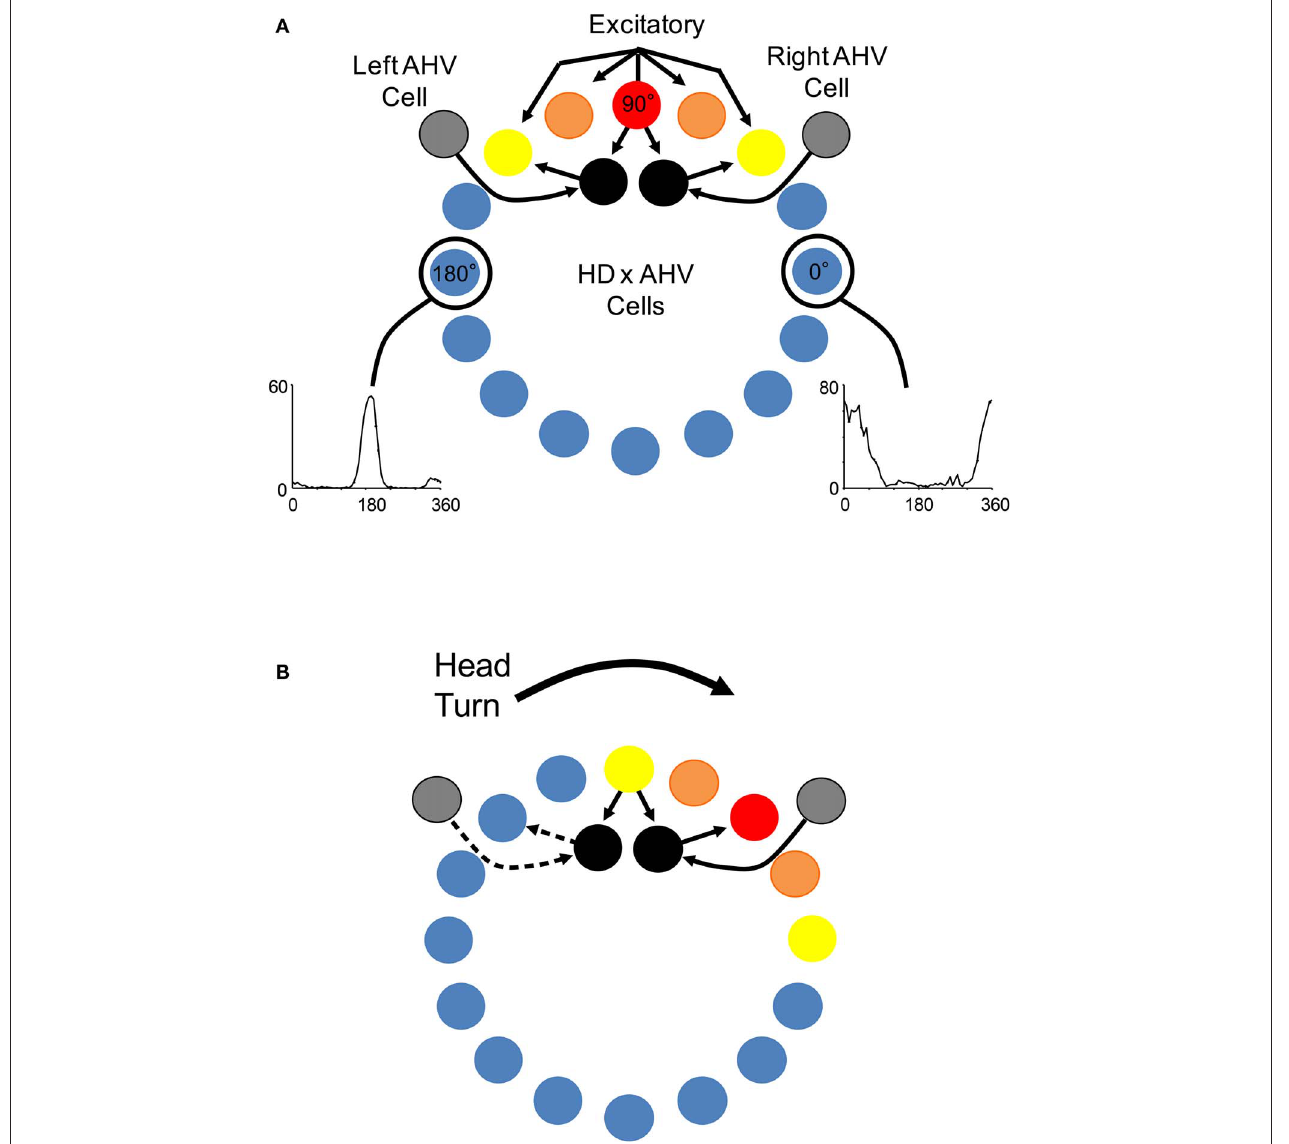
FIGURE 3 | (A) Components of a typical attractor network model of HD signal generation (e.g., Skaggs et al., 1995; Redish et al., 1996; McNaughton et al., 2006). In general, most attractor network models conceptually arrange HD cells in a circle or ring with each HD cell (colored circles) positioned according to their corresponding preferred tuning direction. Each HD cell sends strong excitatory axons to nearby neurons, and weaker excitatory inputs to more distant neurons. Inhibitory projections (not shown) within the network limit net activity resulting in a focused point, or a “hill”, of high activity (warm colors). Movement of the activity hill corresponding to an animal’s head movements is achieved by two additional neural signals: one